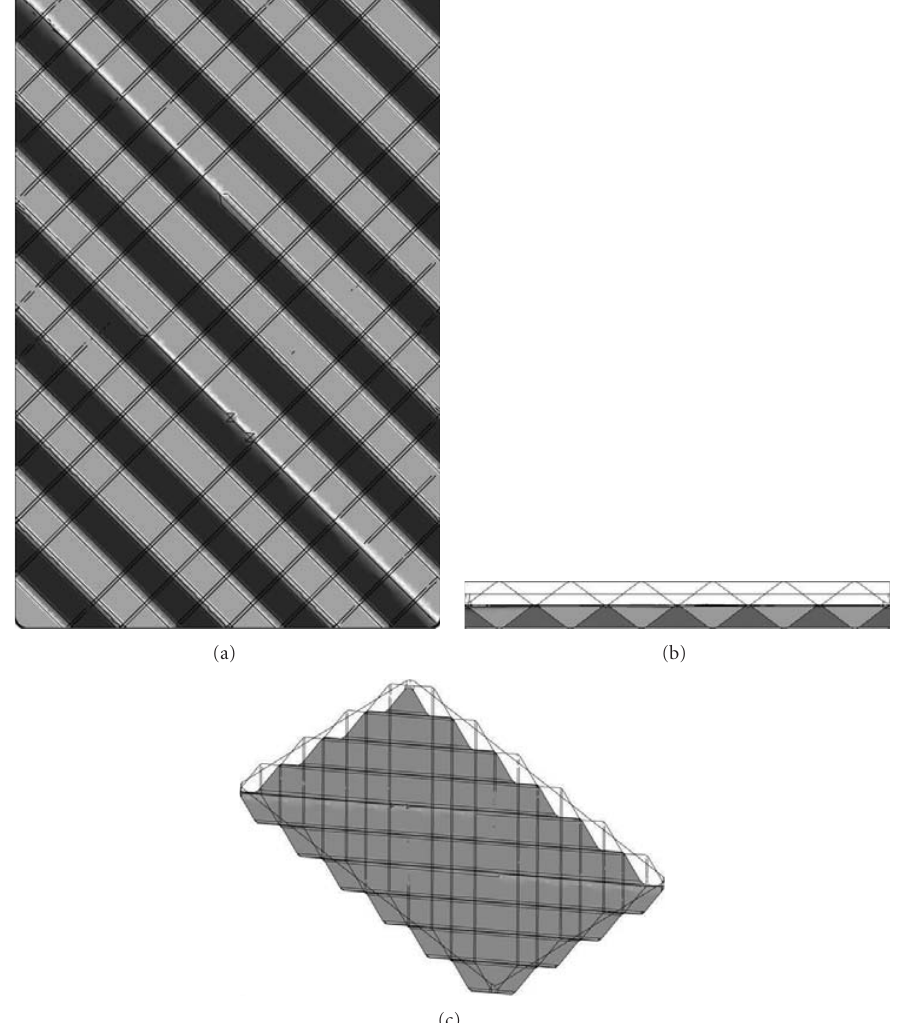
Figure 5: Schematic view of two corrugated sheets of packing with smooth crimp. (a) Top views (b) Side view. (c) Isometric view.